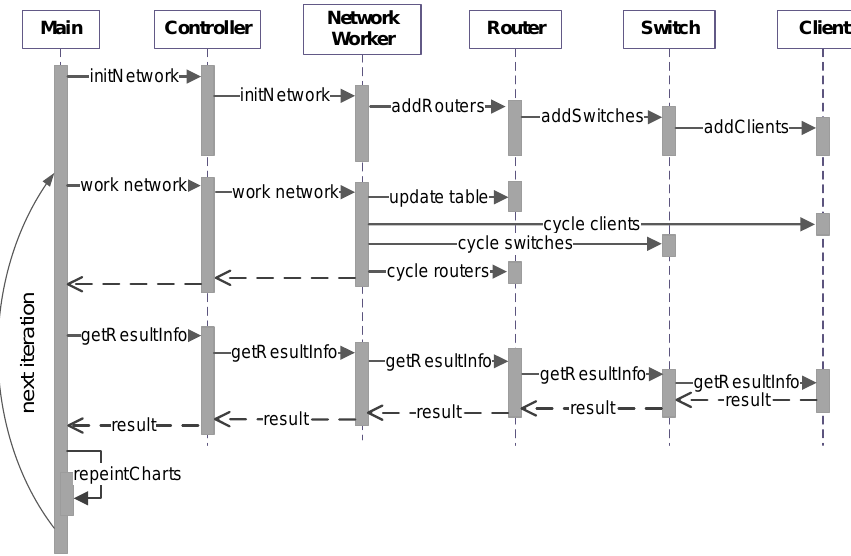
Figure 8. The general algorithm of network operation.